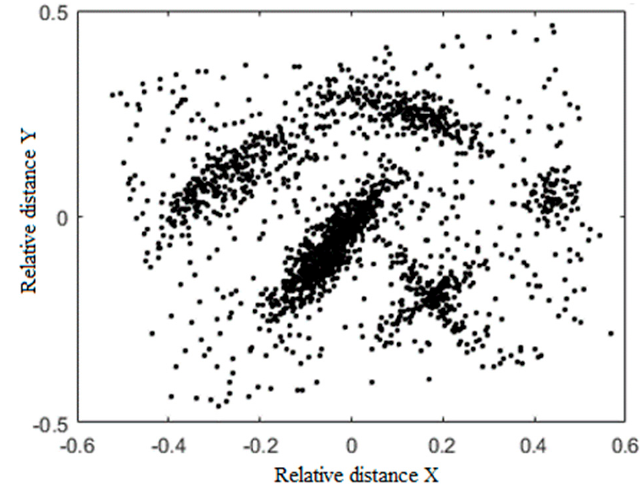
Figure 6. The original data set.